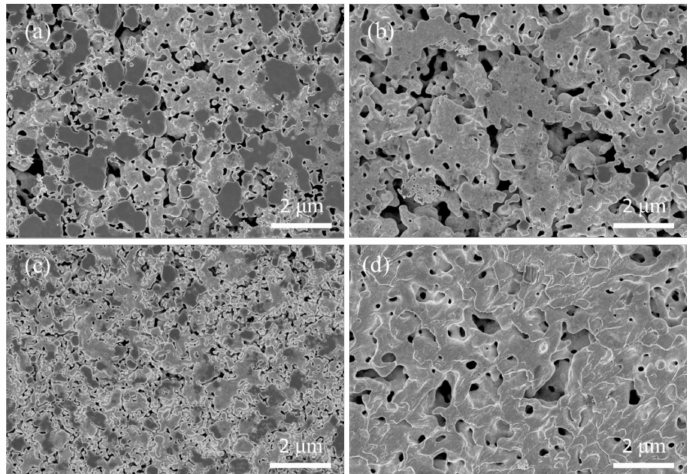
Figure 13. The fracture surfaces of Ag paste sintered at the following different temperatures: ( a ) 200 ◦ C, ( b ) 225 ◦ C, ( c ) 250 ◦ C and ( d ) 275 ◦